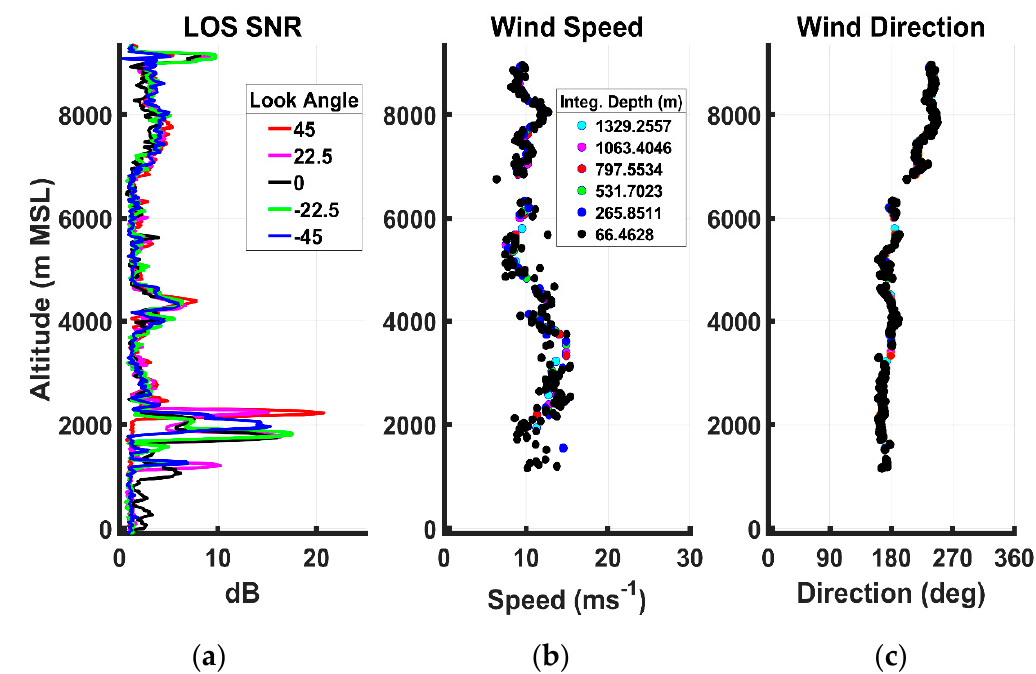
Figure 25. DAWN vertical profiles of SNR ( a ), wind speed ( b ) and wind direction ( c ) in inflow region of convection at 182534Z on 11 June 2017.